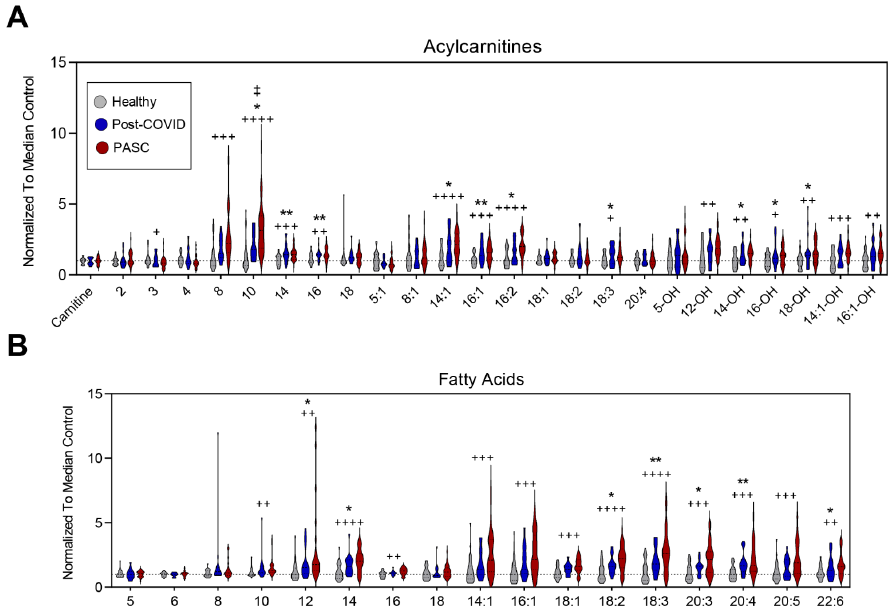
Figure 3. Fatty Acid Oxidation. ( A ) Relative levels of acylcarnitines and ( B ) free fatty acids are depicted as violin plots normalized to median control value. Statistically significant changes noted between * controls and post-COVID, + control and PASC, and ‡ post-COVID and PASC; FDR uncorrected * or + p < 0.05; ** or ++ p < 0.01, +++ p < 0.001, ++++ p < 0.0001.